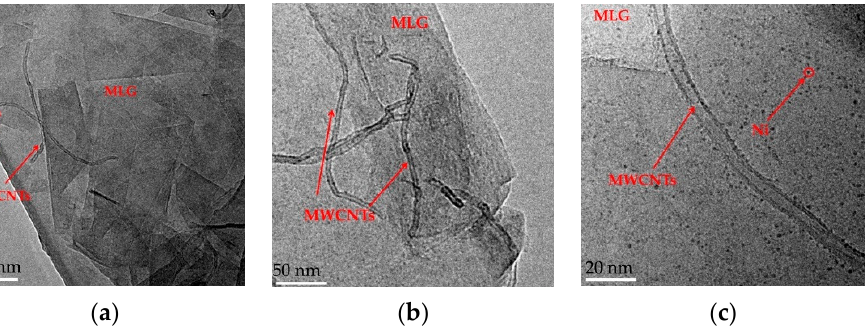
Figure 2. TEM images of composites. ( a ) TEM plot of Ni/CNT/MLG particles at 100nm scale. (b ) TEM plot of Ni/CNT/MLG particles at 50nm scale. ( c ) TEM plot of Ni/CNT/MLG particles at 20nm scale.